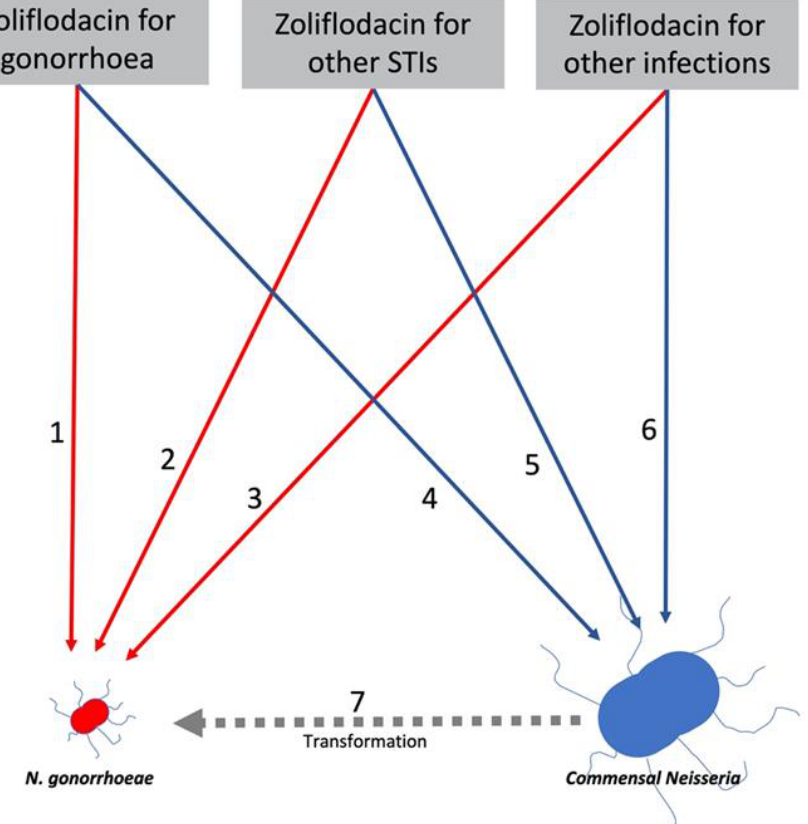
Figure 2. Model of relationship between zoliflodacin consumption for 3 indications and induction of zoliflodacin resistance in N. gonorrhoeae (NG: red) and commensal Neisseria (blue). Zoliflodacin is a promising, novel anti-gonococcal therapy that also shows promise for a range of other infections. Zoliflodacin (ZF) usage could select for AMR directly in NG via 1. ZF used to treat NG, 2. ZF used to treat other STIs and 3. ZF used to treat other infections. It could also select for AMR in commensal Neisseria via 4. ZF used to treat NG, 5. ZF used to treat other STIs or 6. ZF used to treat other infections. Each of these could select for ZF resistance in commensal Neisseria , which could then be transferred to NG via transformation (7). The probability of ZF inducing AMR in NG (1,2,3) and commensal species (4,5,6) could be determined via in vitro experiments. These experiments could also estimate the efficiency of transformation given the co-occurrence of NG and a specific commensal Neisseria (7). The commensal Neisseria in the figure is bigger than NG to reflect the orders of magnitude of the higher prevalence of commensal Neisseria